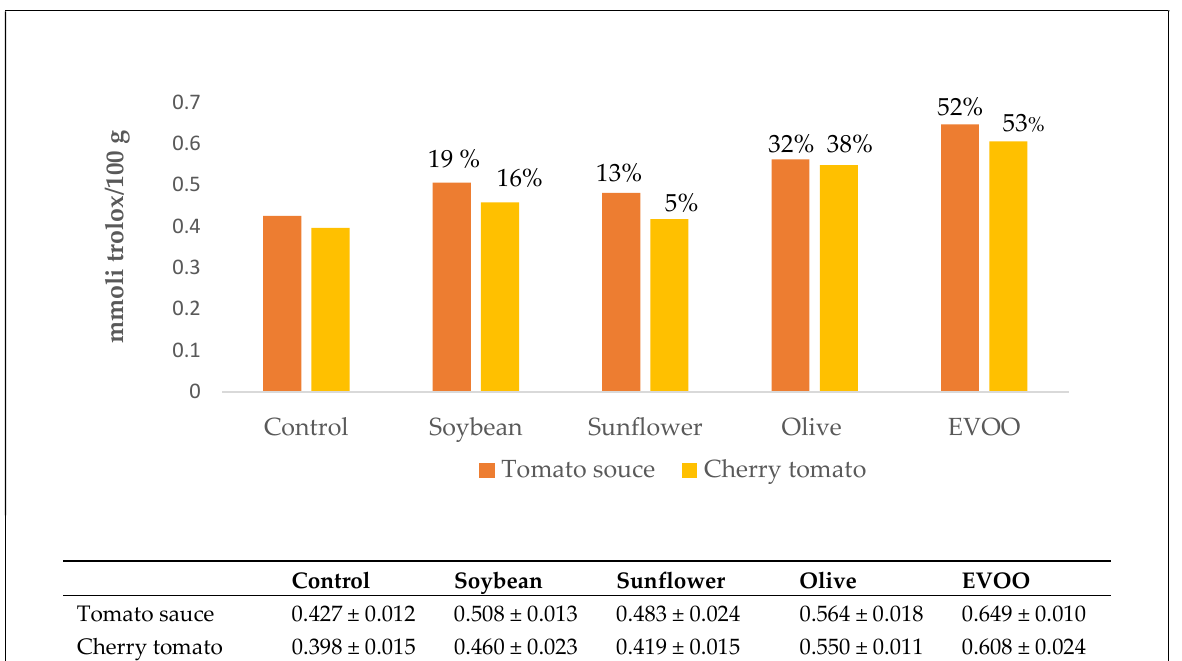
Figure 1. Amount of phenols expressed as mg/100 g of pizza measured on lipophilic extracts as a function of the type of oil and tomato used.